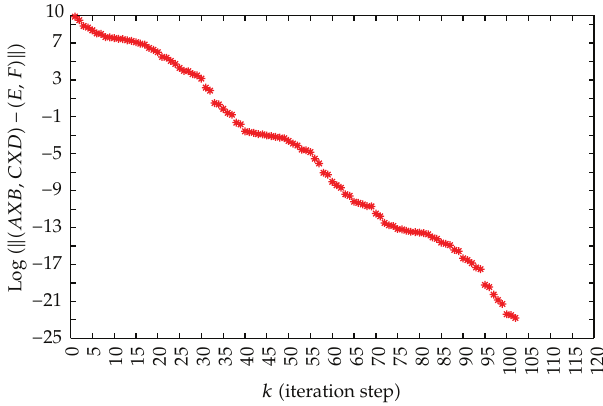
Figure 3: Convergence curve for the Frobenius norm of the residual for Example